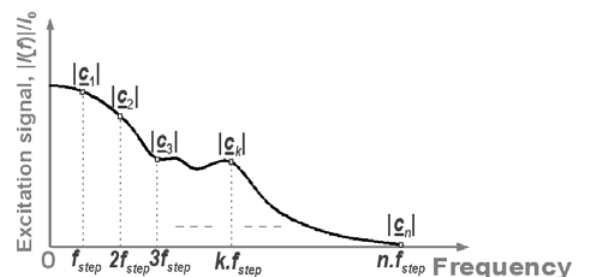
Figure 2: Extraction of the frequency spectrum coefficients from the excitation signal spectrum.